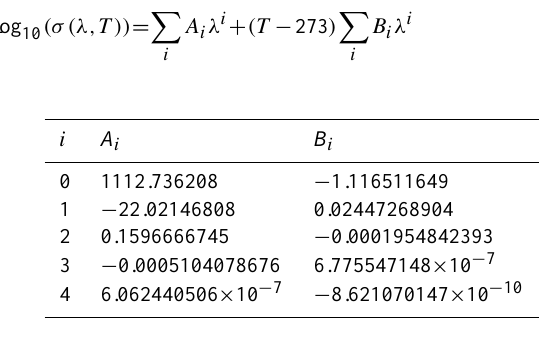
Table 3. CCl 4 absorption cross section parameterization for 200